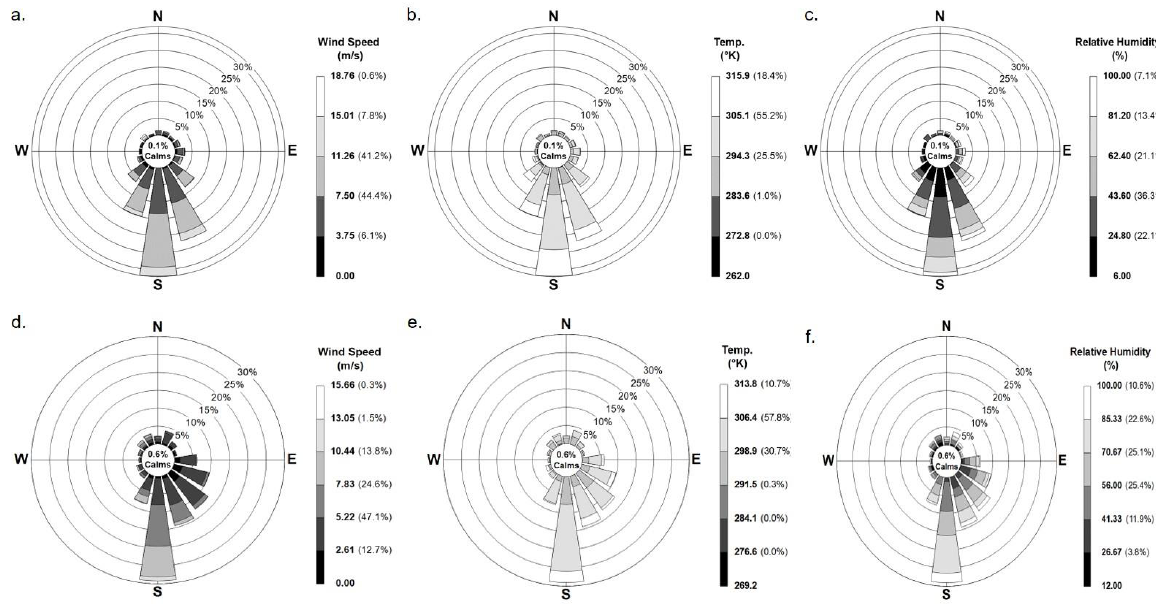
Figure 1. Meteorological conditions in the Feedlot C ( a – c ) and Dairy B ( d – f ) for June 2020.